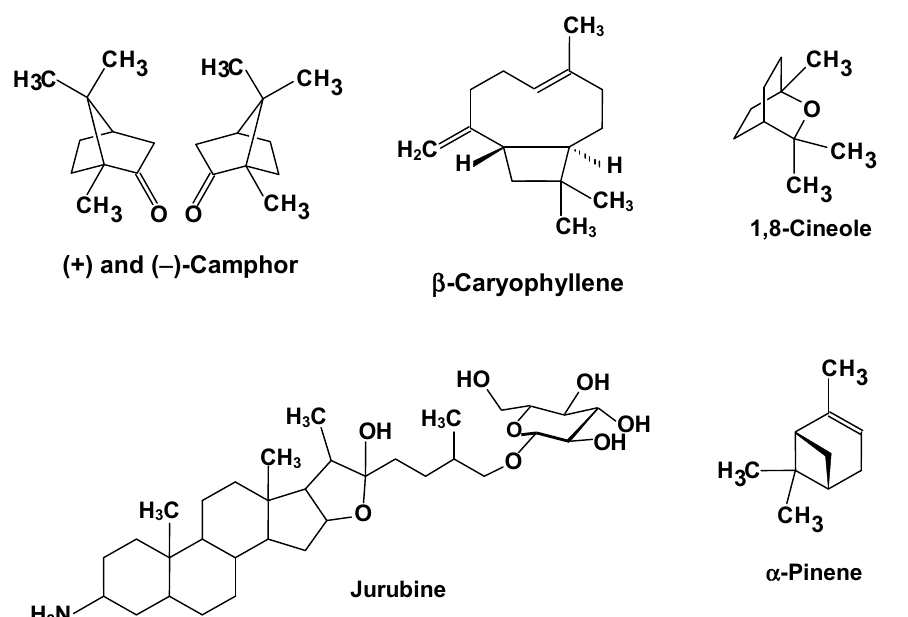
Figure 6. Examples of lipophilic compounds and the saponin jurubine, possibly involved in the hepatoprotective action of several Brazilian plants.